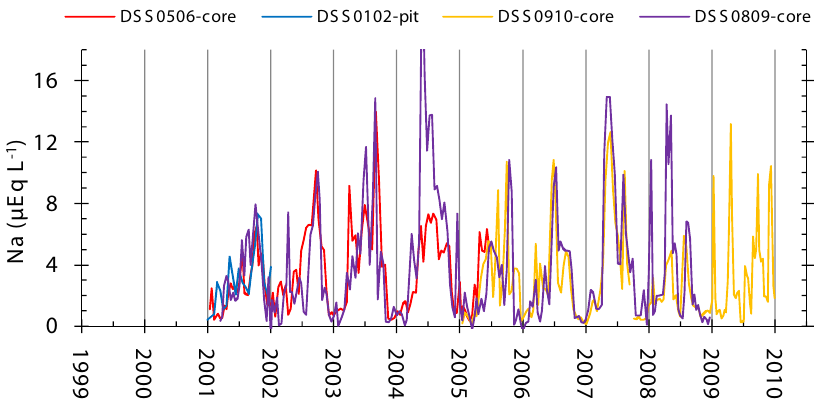
Fig. 4. Intercomparison of Na + concentrations from the same ice core and snow pit records used in the analysis of 10 Be reproducibility. Standard measurement error in Na + concentrations are ∼ 15%. Note that trace chemistry was not measured on the DSS0506-pit. period in the core, ( 3 . 95 ± 1 . 4 ) × 10 3 atoms g − 1 . In